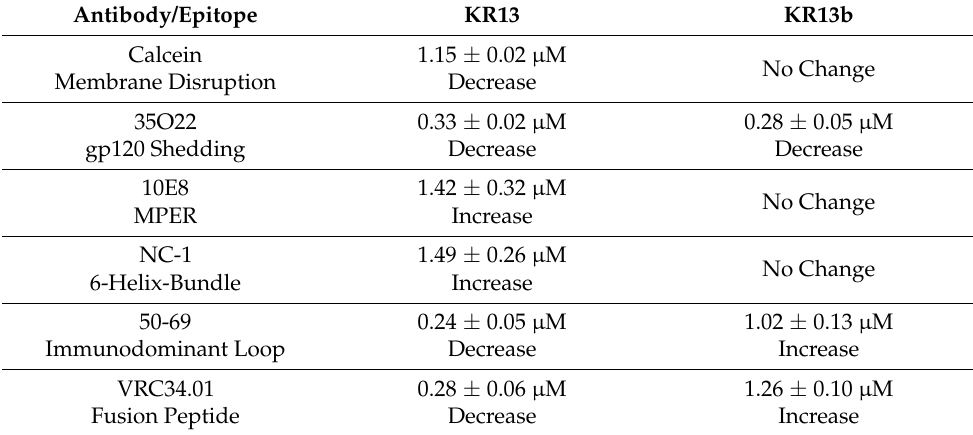
Table 1. Collected EC 50 values for KR13 and KR13b transformations with relative change in exposure. EC 50 values are presented as x 0 ± the standard error of x 0 .